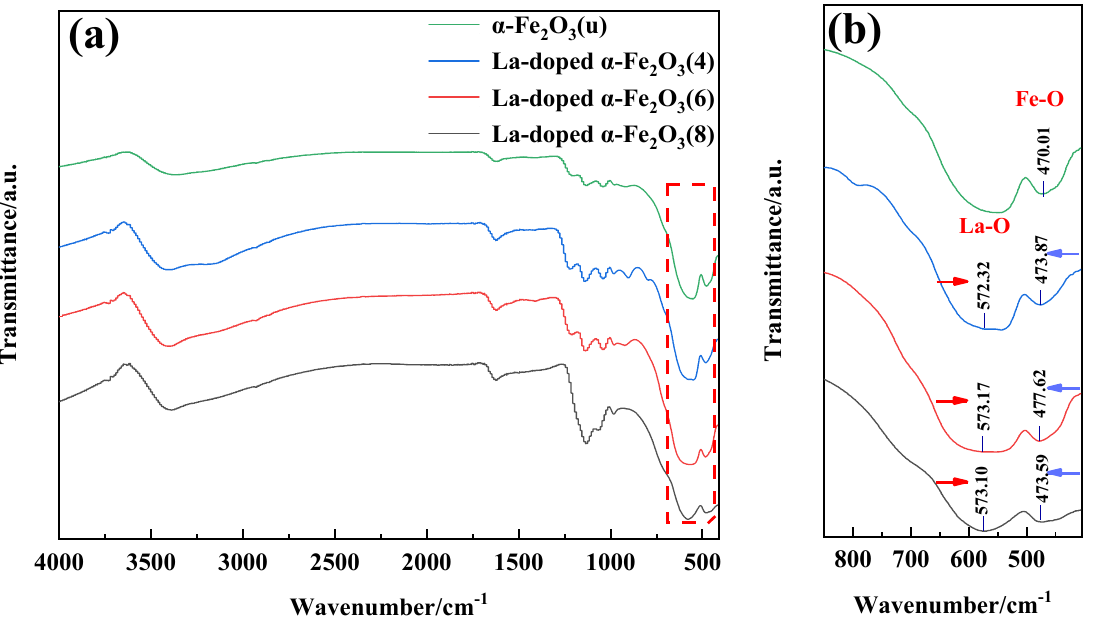
Figure 6. FT-IR spectra of α -Fe 2 O 3 (u) and La-doped α -Fe 2 O 3 (x) (x = 4, 6, 8), ( a ) 410~4000 cm − 1 ; ( b ) 410~750 cm − 1 .